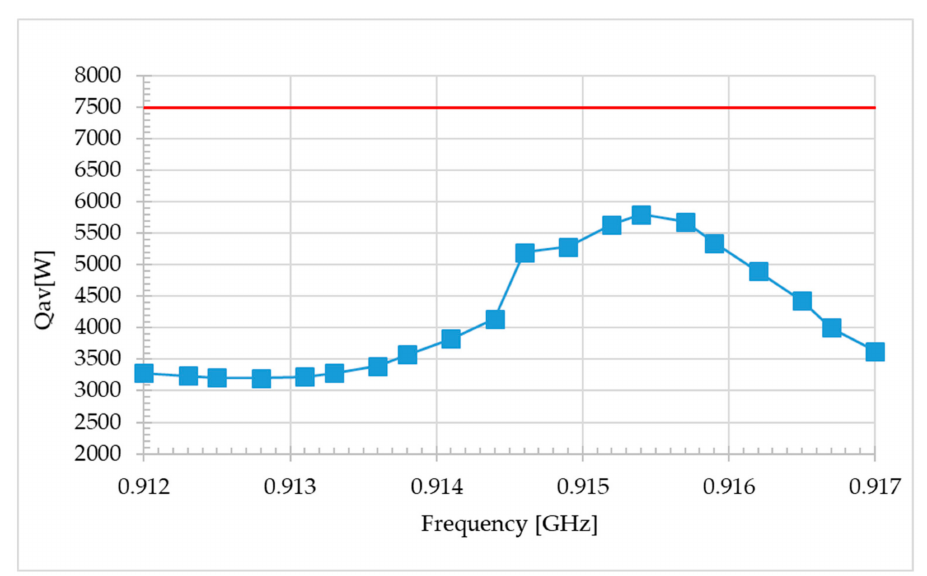
Figure 7. Volume integral of the power density—i.e., dissipated power in the load alone, as a function of